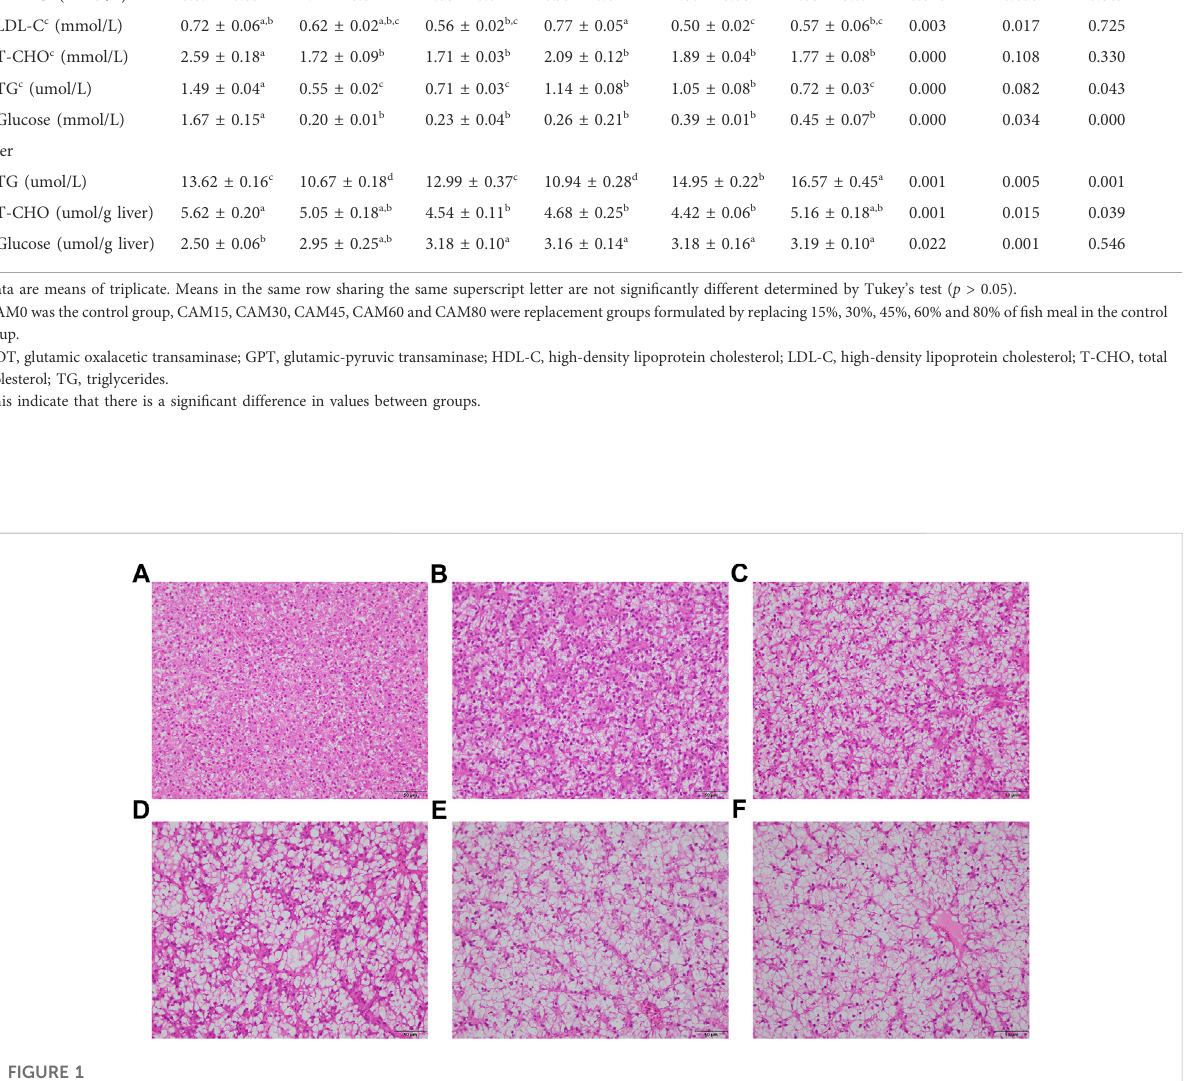
amino acid transporter 1 ( tat1 ), increased fi rst and then decreased with signi fi cantly quadratic pattern ( p < 0.05), and peak value was observed in fi sh fed with diet CAM30 or CAM45 (Figure 2).